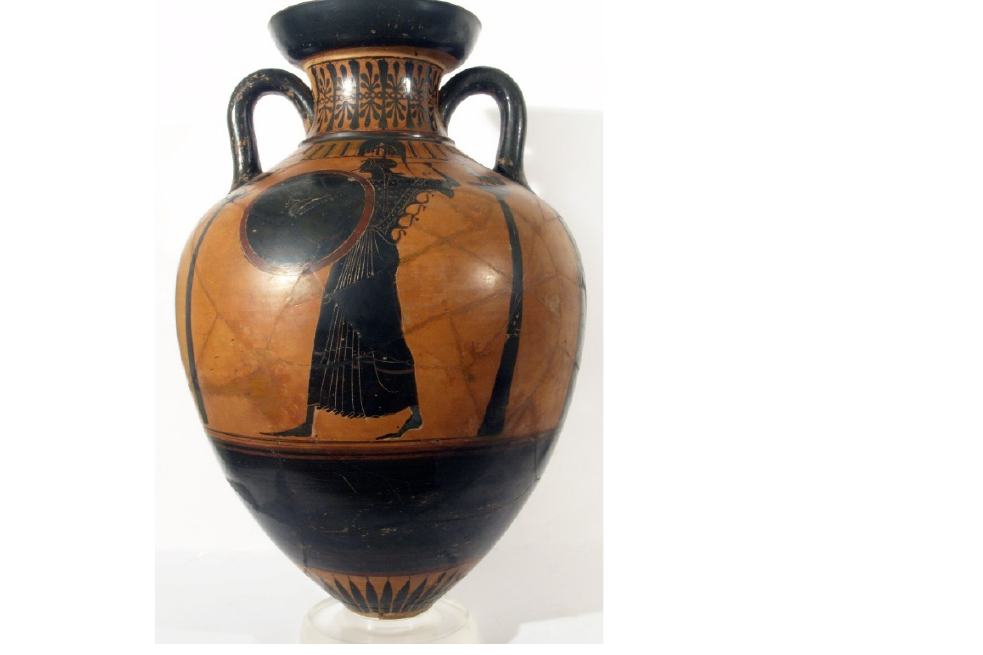
Figure 2. Pseudo ‐ Panathenaic Amphora, Mainz, Johannes Gutenberg Universität, 74. Figure 2. Pseudo-Panathenaic Amphora, Mainz, Johannes Gutenberg Universität,